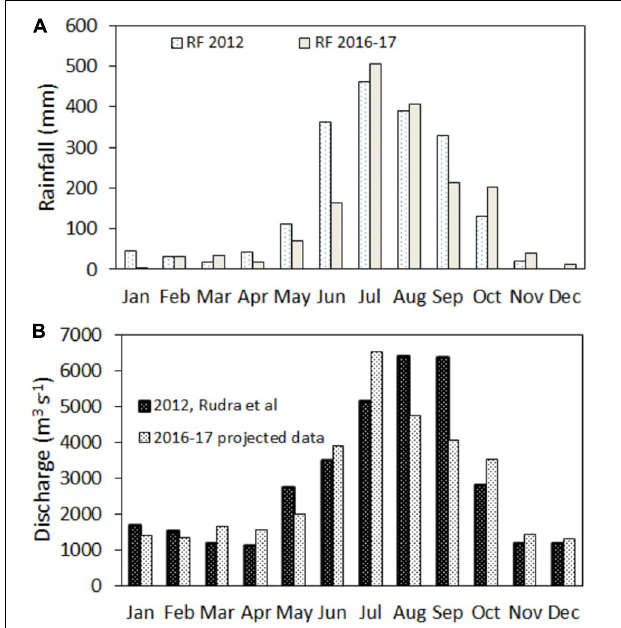
FIGURE 2 | (A) Rainfall (RF, in mm) in 2012 and mean RF of 2016–2017 and, (B) observed freshwater discharge (m 3 s − 1 ) of the Hooghly River in 2012